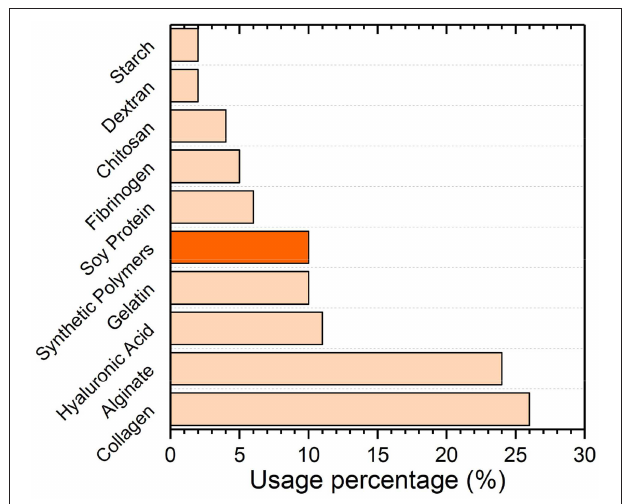
FIGURE 1 | Most used polymers in bioprinting-related